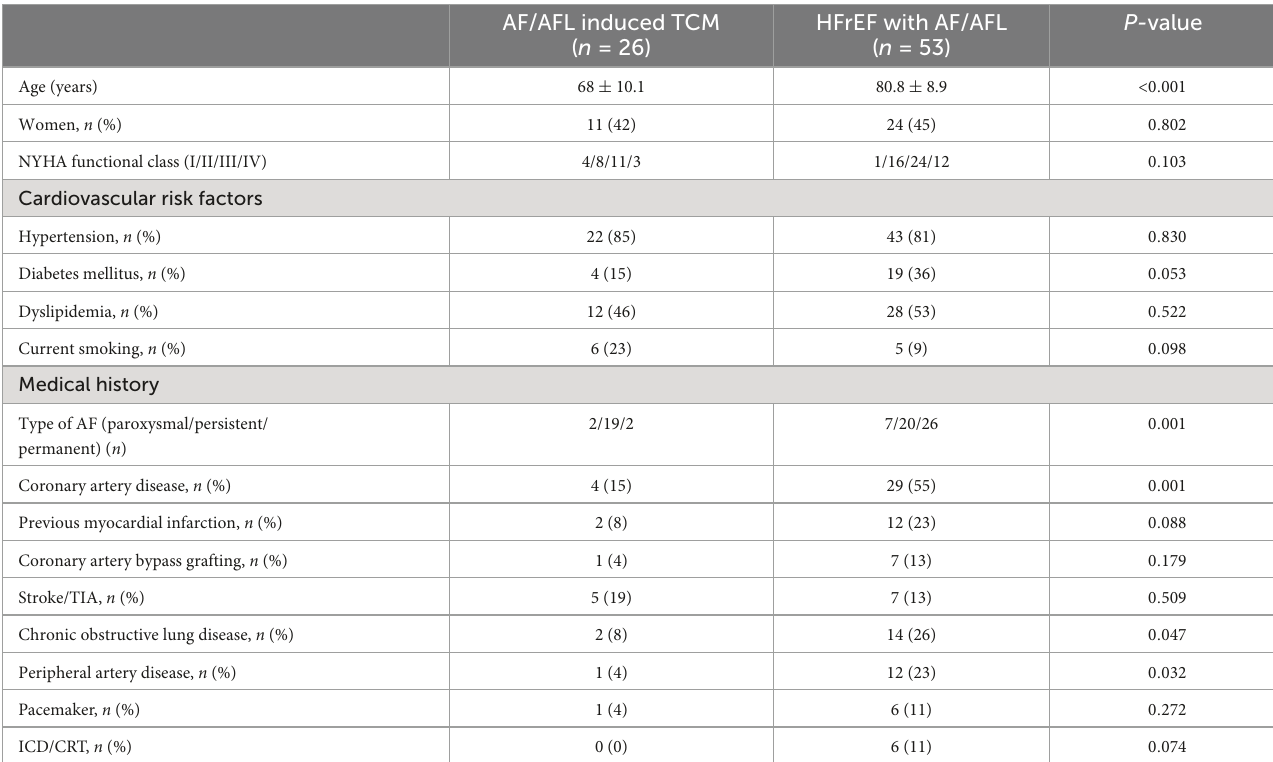
TABLE 1 Clinical characteristics of study patients ( n =